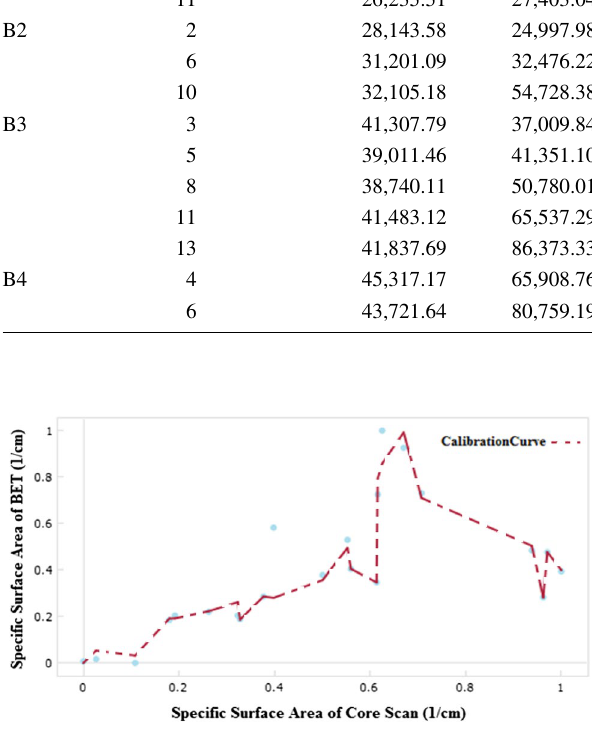
Fig. 9 Calibration curve of core